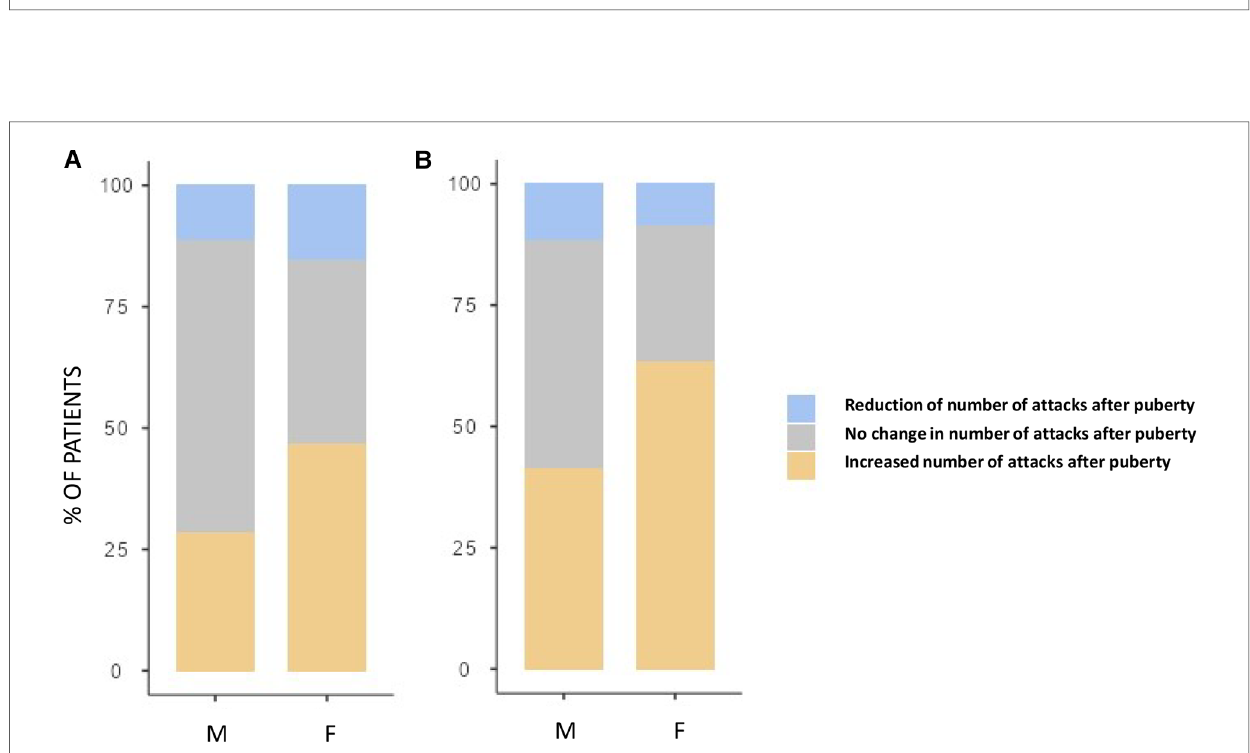
FIGURE 4 Proportion of subject reporting a reduction (blue), an increase (orange), or no change (gray) in the monthly mean number of attacks after puberty in male (M) and female (F) between 1 year before vs. 1 year after puberty ( A ) and 3 years before vs. 3 years after puberty ( B ) Signi fi cantly more females reported an increase of attacks in both periods: 28.3% vs. 46.6%, p =0.048 and 41.2% vs. 63.2%, p =0.022,